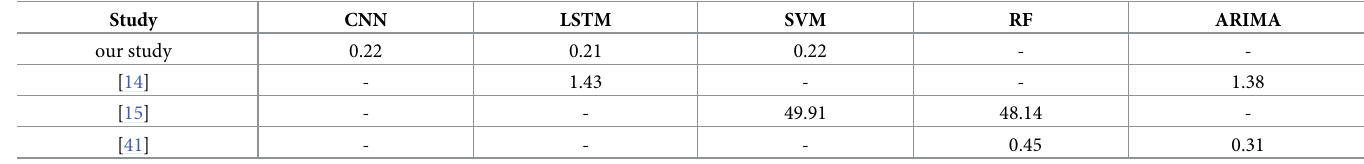
Table 5. Root Mean Square Error (RMSE) performance comparison with the existing diarrhoea prediction studies. Study our